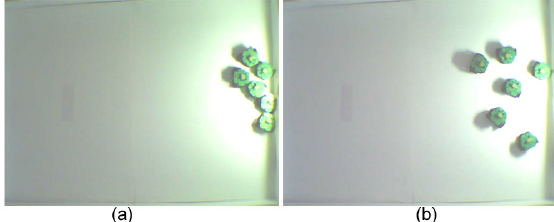
Fig. 5. Aggregation time and number of collision for each robot versus the population size in two arena sizes.